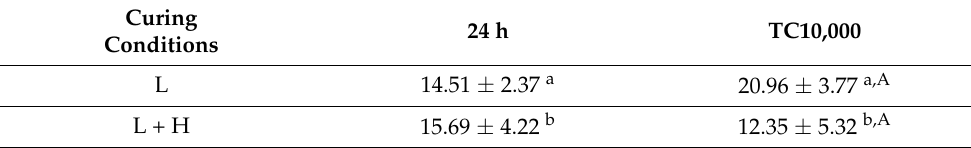
Table 3. Sear bond strength of the UDMA based material and PMMA used in this study.